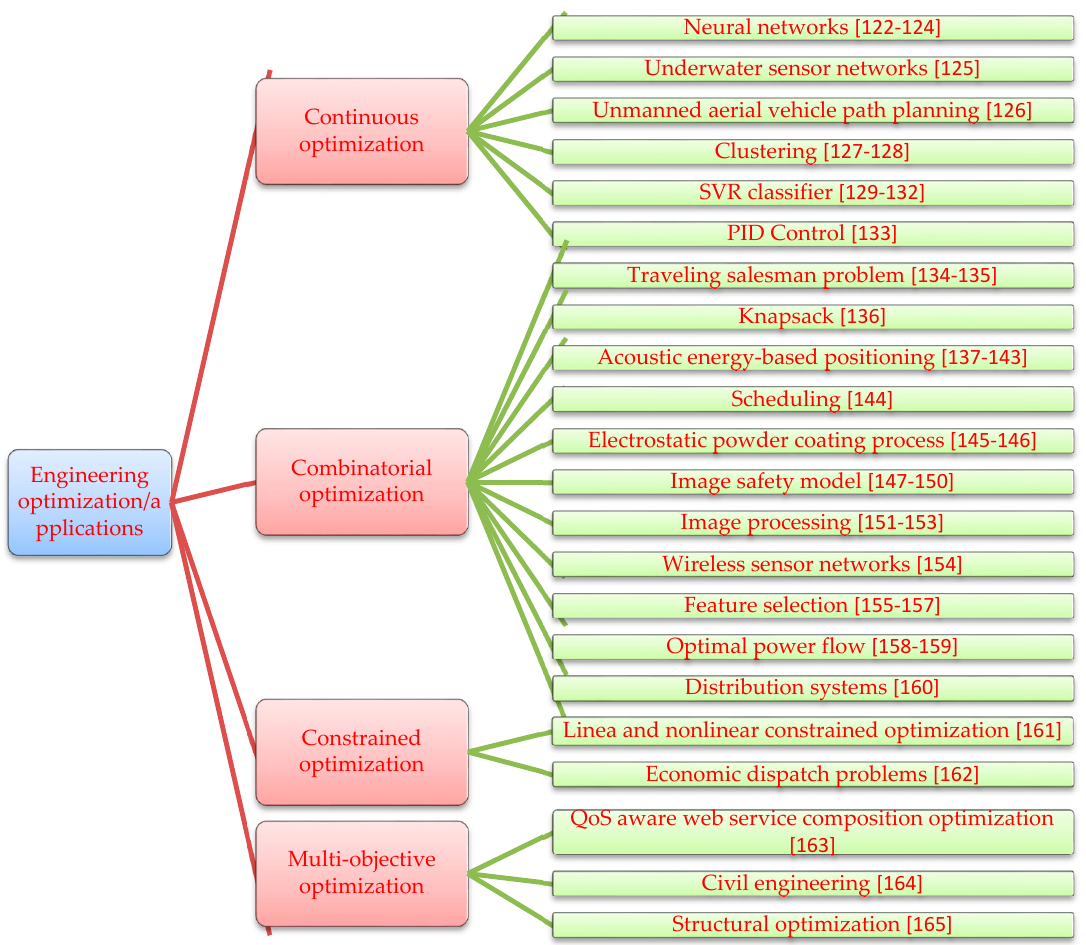
Figure 5. Engineering optimization/applications.